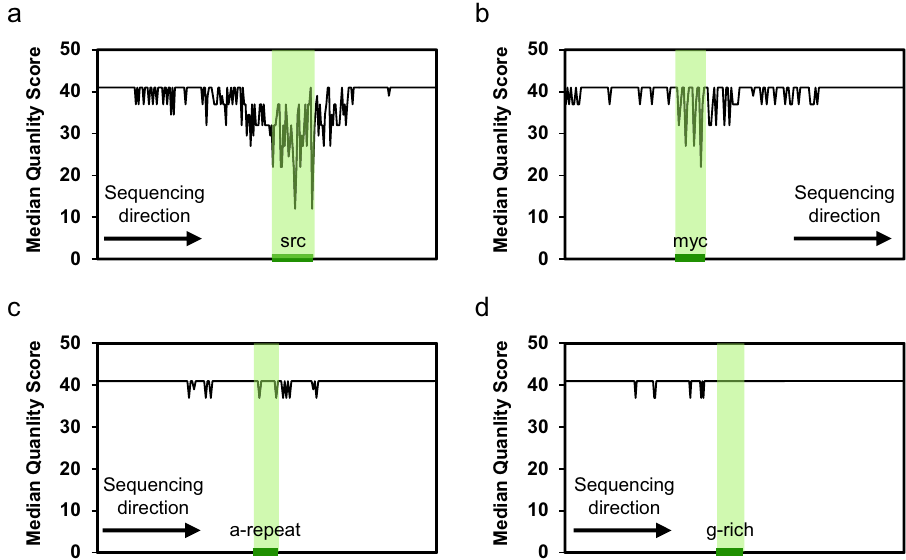
Fig. 2 Sequencing quality of four known controls. a Src, a sequence containing a stable G4 structure; b myc, a sequence containing a stable G4 structure; c a-repeat, negative control; d g-rich, negative control. The green shadows present the regions of the than the remaining segments. Over 40% of PG4-positive seg- sequences at the 3 ′ end were cut from the plus strand of the ments contained over 15 loci whose quality scores decreased no human genome. The remaining regions of the plus stand that did <4 in comparison with the loci before PG4s, and only 4.05% of not contain PG4s were cut into 75 nt segments. The analysis non-PG4 segments passed the criteria (Supplementary Table 2). based on approximately one million reads (~45× of the plus strand) generated by the standard pipeline showed more sig- ni fi cant quality fl uctuations in the segments containing PG4s